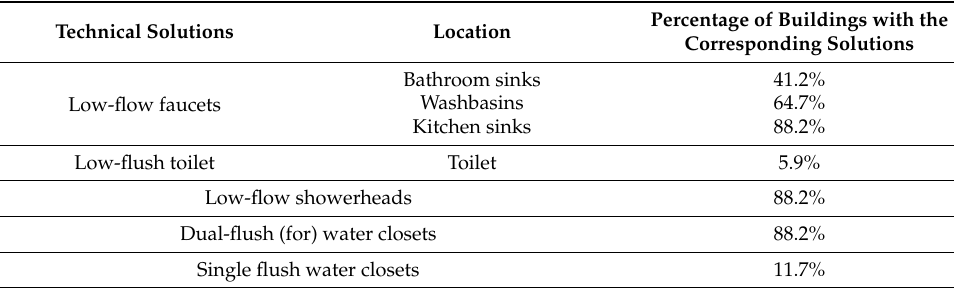
Table 6. Summarized water-related technical solutions of the 17 residential complexes in South Africa with EDGE certification